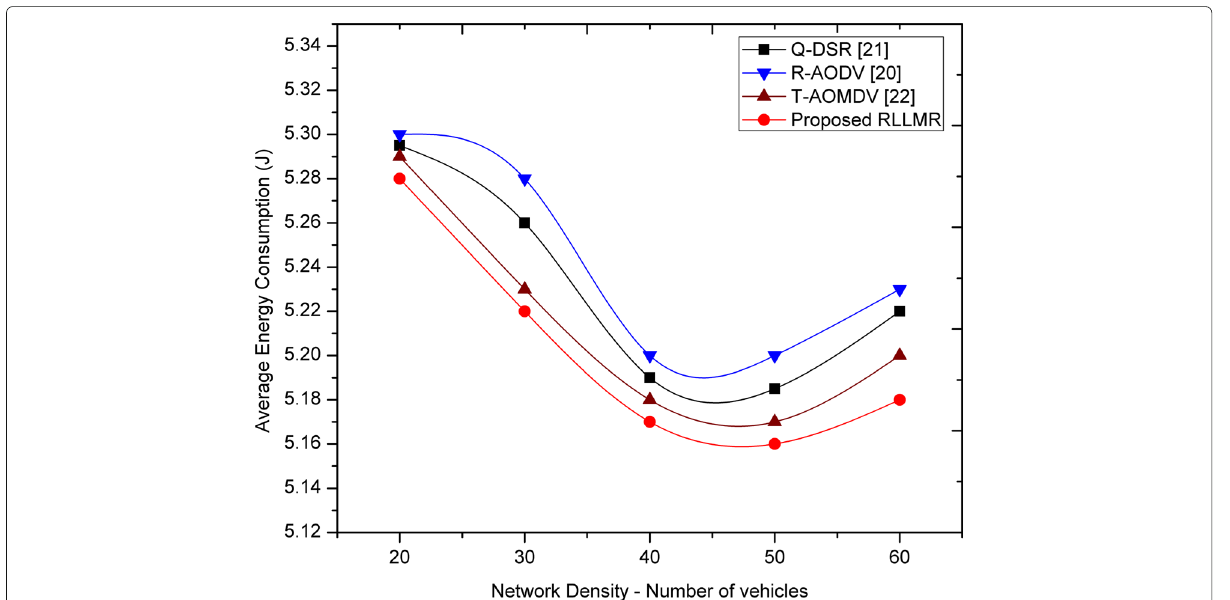
Fig. 11 Effect of different vehicles over average energy (average speed 60 km/h, R 1000 m, t 10 s)